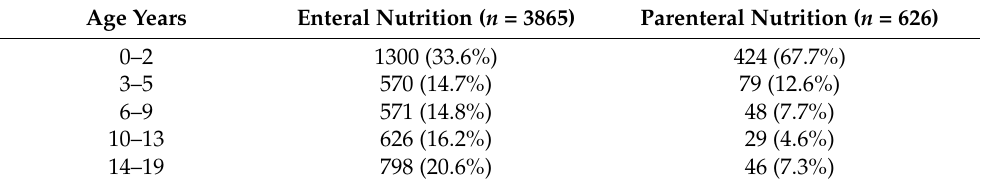
Table 1. Patient age by year of birth at the start of HEN and HPN procedures.